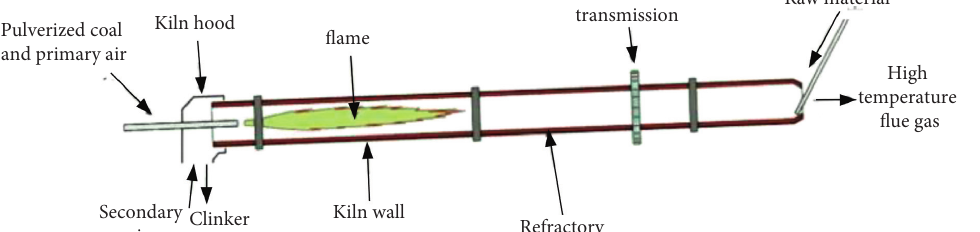
Figure 3: Structure diagram of rotary kiln.